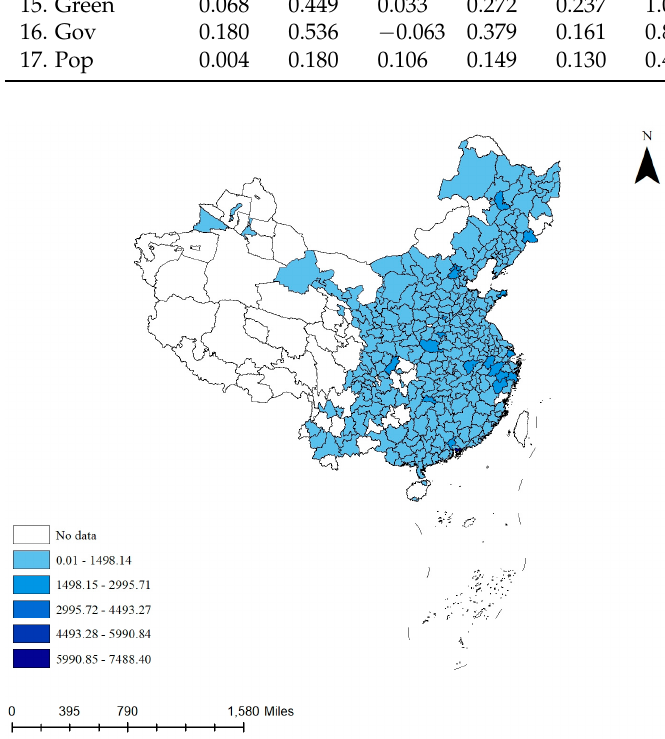
Figure 4. The spatial distribution of land transaction prices in the study area from